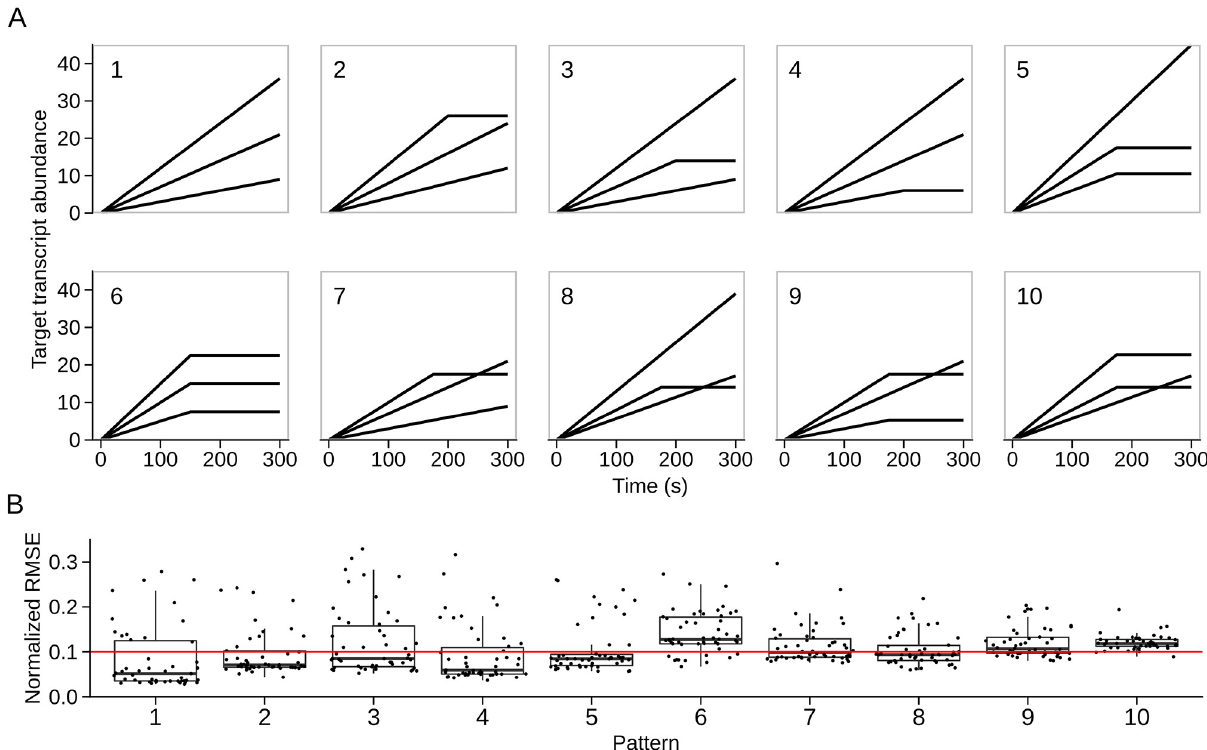
Fig 3. Quantitative assessment of pattern achievability. A: The 10 target gene expression time-course patterns that we simulated are displayed as black lines representing general patterns (each of which has 6 possible gene arrangements). B: For 50 replicate simulations of each pattern, shown are the lowest achieved normalized-RMSE values. All patterns had at least two successful independent evolutionary simulations, as determined by the red line highlighting a normalized-RMSE value of 0.1.